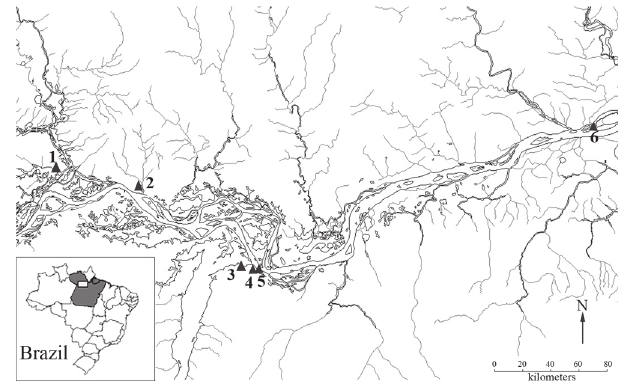
Fig. 1. Map of collection sites of Hoplias malabaricus in the lower Amazonas River. Localities: 1 - Sapucuá lake; 2 - Óbidos; 3 - Juá lake; 4 - Urumari stream; 5 - Maicá lake; 6 - Almeirim. A map of Brazil (box on left corner) with the Pará State shaded in gray indicates the studied area by a white rectangle.